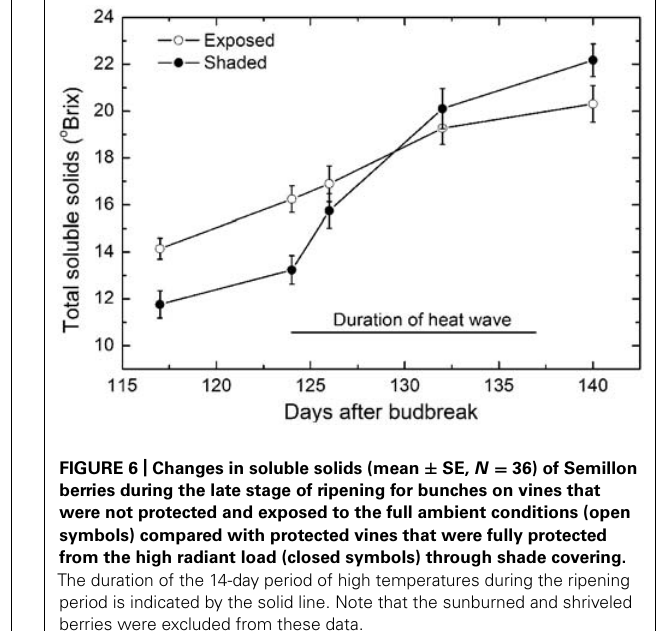
FIGURE 6 | Changes in soluble solids (mean ± SE, N = 36) of Semillon berries during the late stage of ripening for bunches on vines that were not protected and exposed to the full ambient conditions (open symbols) compared with protected vines that were fully protected from the high radiant load (closed symbols) through shade covering. The duration of the 14-day period of high temperatures during the ripening period is indicated by the solid line. Note that the sunburned and shriveled berries were excluded from these data.